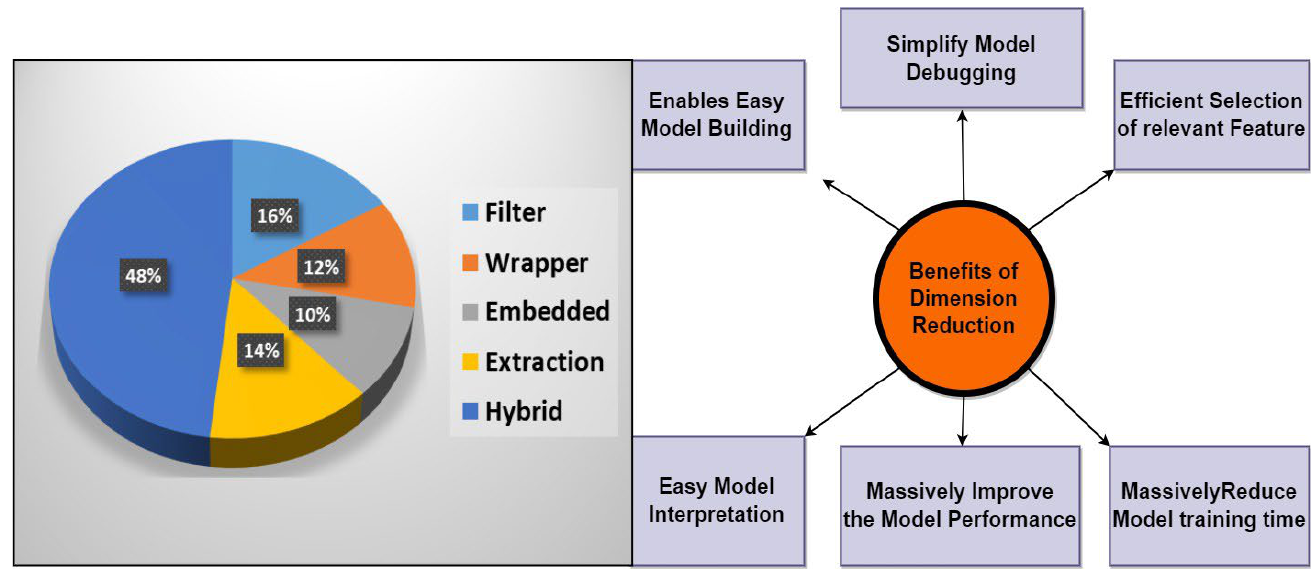
Figure 3. Benefits of the dimension reduction method.